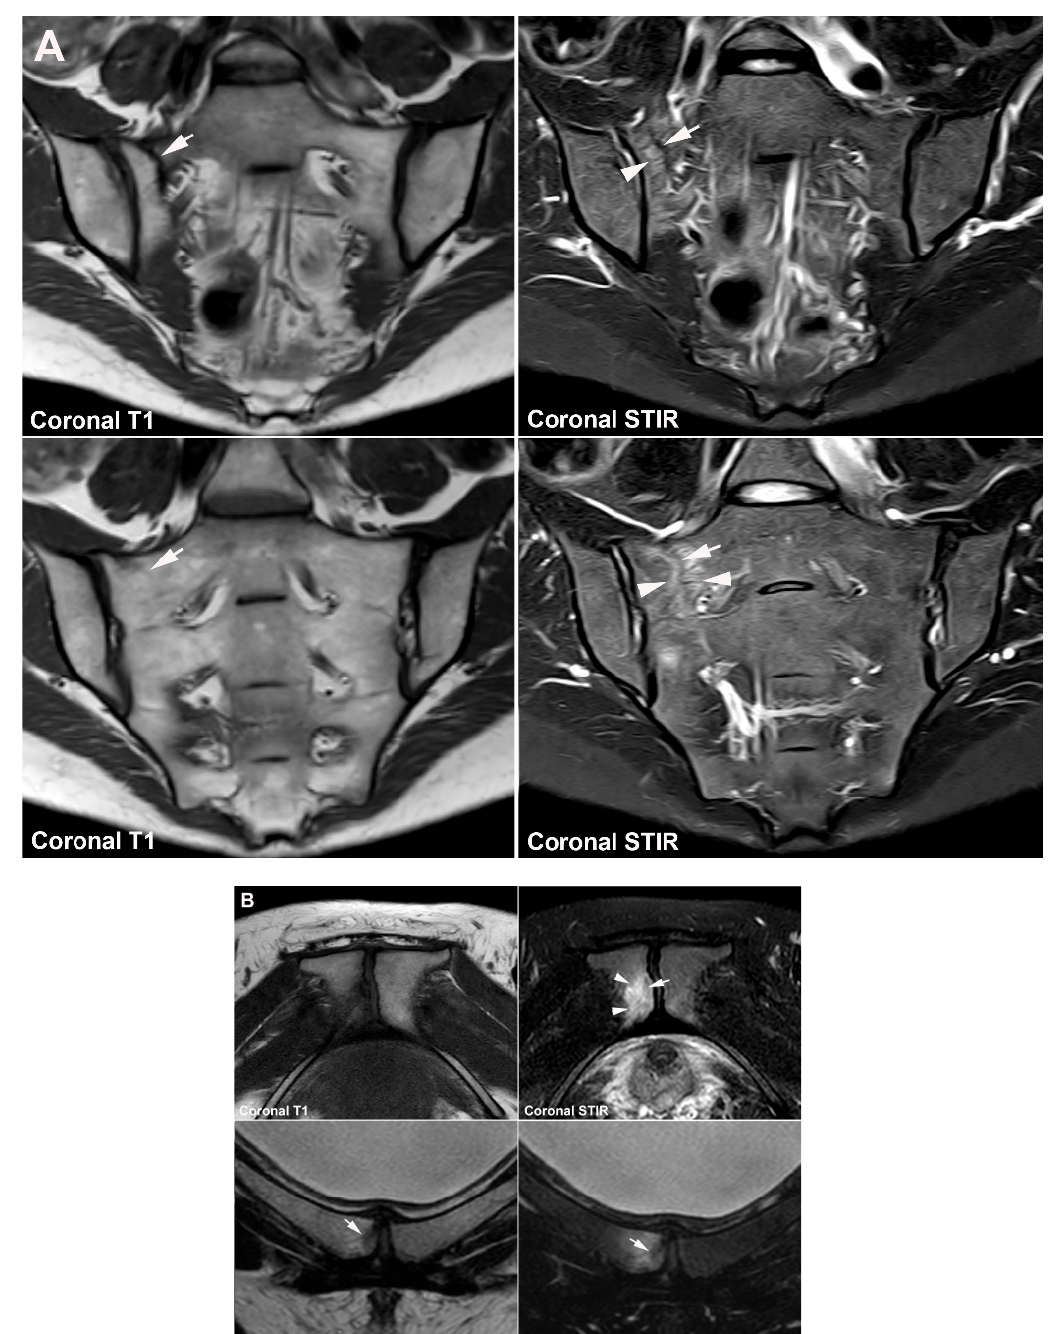
Figure 22. Sacral stress fracture. ( A ) MRI of the SIJ in a 32-year-old woman with pelvic pain during 3 months after a protracted childbirth, semi-coronal T1 and STIR images anteriorly (upper image row) and in the middle of the joint (lower image row) showing an area with BME (arrowheads) around a sclerotic line (arrows) consistent with a fracture line which is most clearly delineated on the T1-weighted image anteriorly. ( B ) Supplementary MRI of the symphysis, semi-coronal T1 and STIR, and semi-axial T2 and T2FS revealed a concomitant fracture in the right pubic bone (arrows) with surrounding BME (arrowheads).